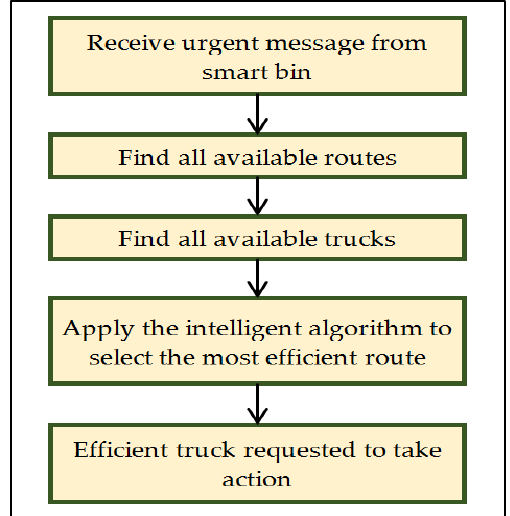
Figure 15. Procedures for decision making.